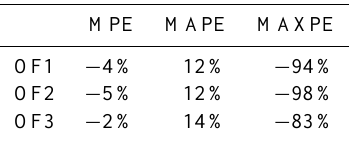
Fig. 7: Box plots comparing calibration results of DSM, SIMPSA, PSO and SCE-UA. All months and repetitions are lumped together, no averages have been taken.